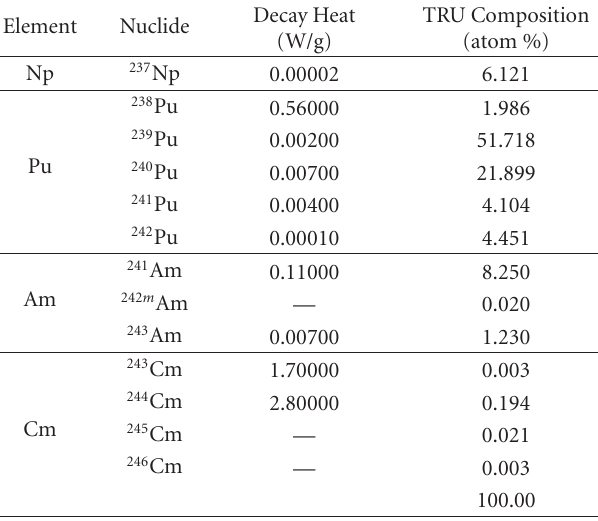
Table 2: PWR TRU vector (41,200 MWd/MTHM, 3.75% BOL enrichment, 23 years decay).